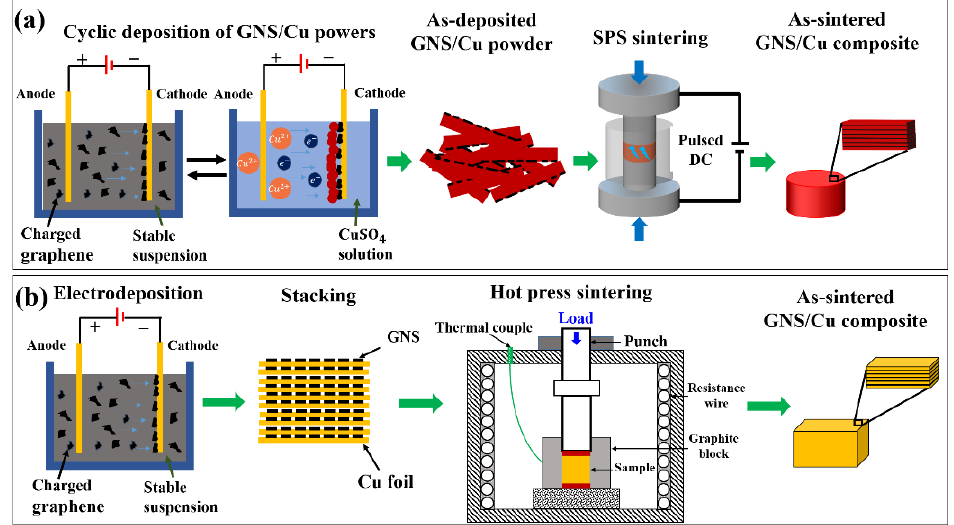
Figure 1. Schematic diagram for the fabrication of ( a ) laminated GNS/Cu composites by alternative depositing followed by SPS sintering and ( b ) laminated GNS/Cu composites by direct depositing of GNSs on cold-rolled Cu foils followed by hot-press sintering.